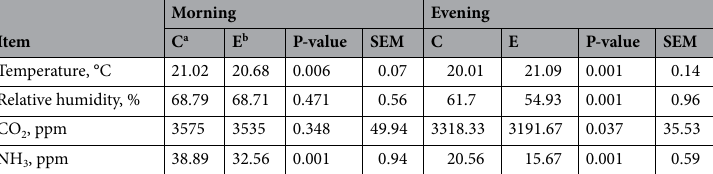
Table 6. The quality of the air environment in the piglet pens. a Control group fed complete mixtures without halloysite. b Experimental group fed complete mixtures with halloysite